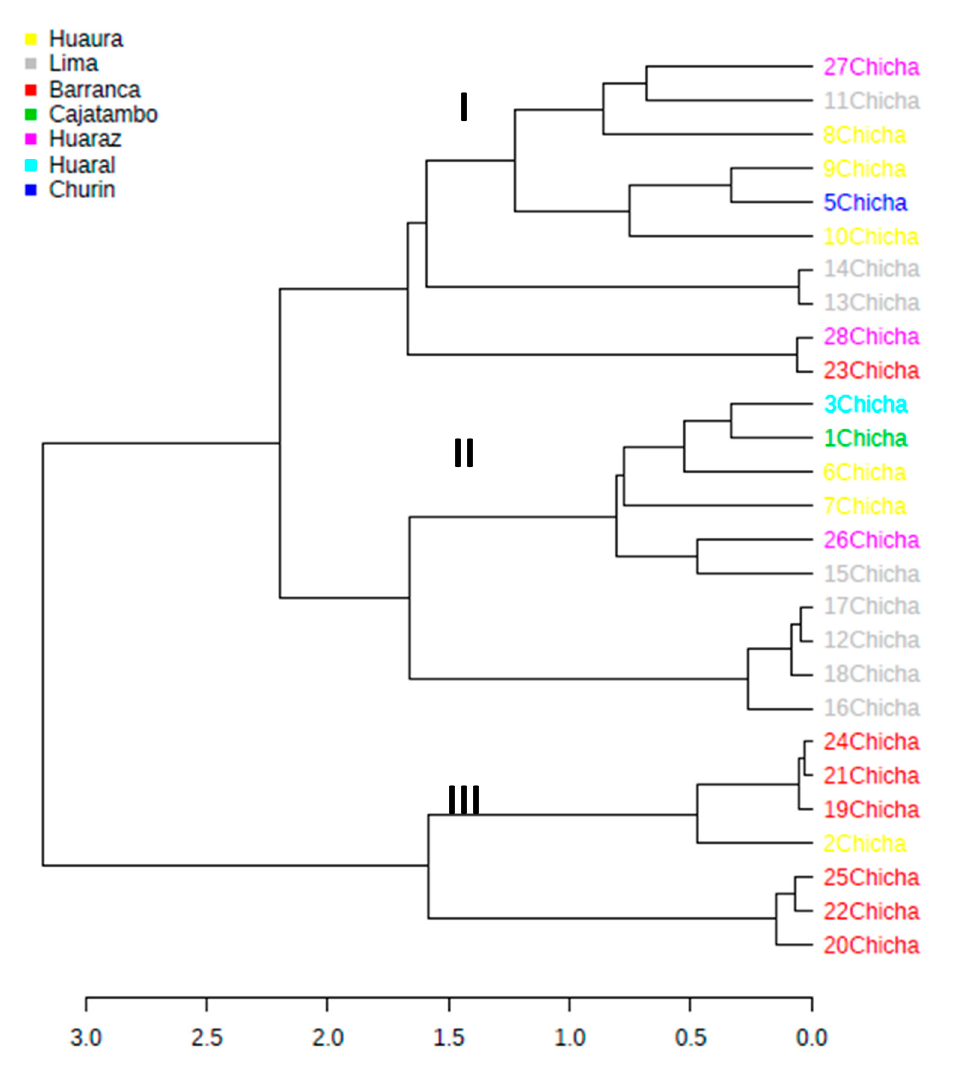
Figure 1. Cluster analysis of bacterial communities based on Bray–Curtis similarity. The analysis pattern includes all OTUs abundance data of the 27 chicha samples from the seven production provinces.